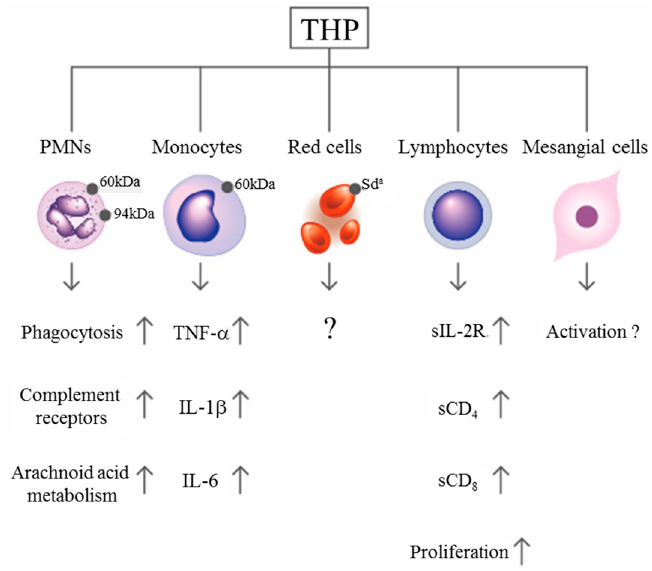
Figure 2. Scheme showing the immunological effects of Tamm–Horsfall protein (THP) after binding with surface receptors on different blood cells.